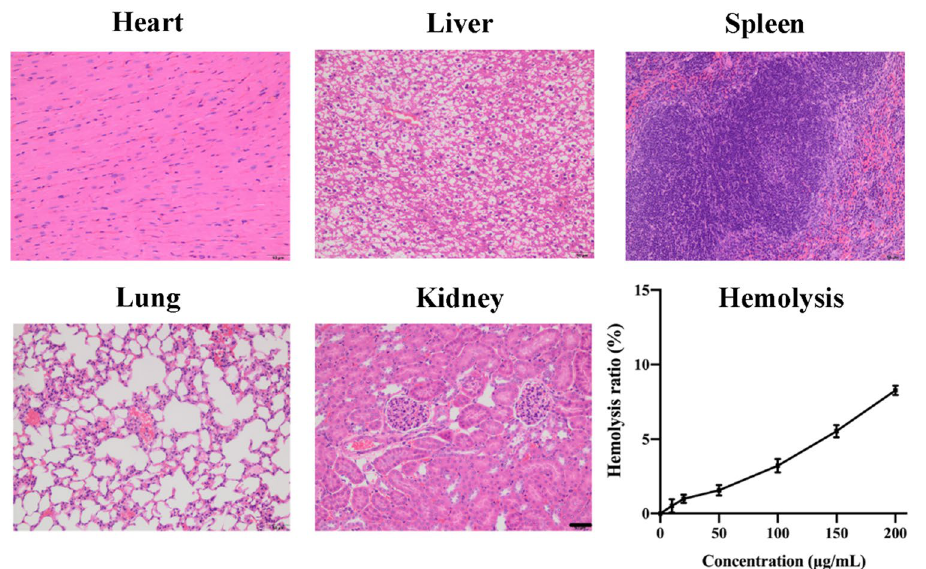
Figure 11. The HE staining result of major organs from mice treated with AS/GOD@HAZnO NPs, Scale bar = 50 μm. The curve represents the hemolysis ratio of AS/GOD@HAZnO NPs at different